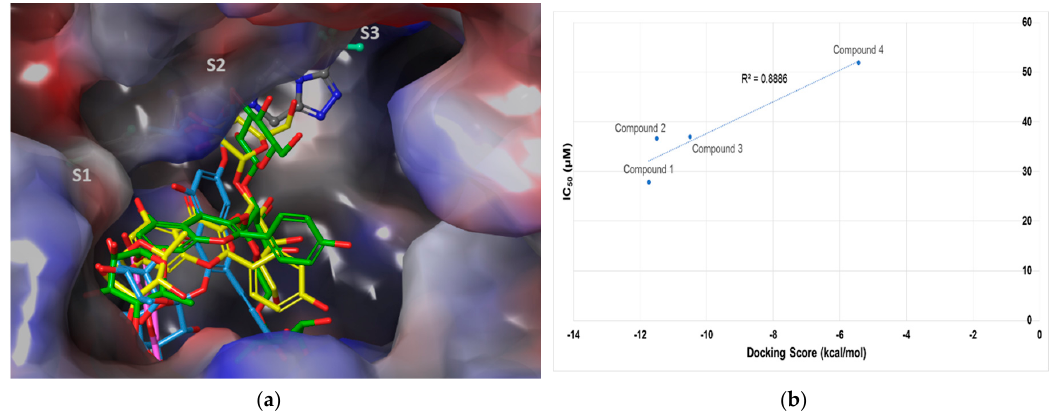
Figure 3. ( a ) The binding poses of all docked compounds in the binding pockets/active sites of human dipeptidyl peptidase IV. The binding pockets/active sites are labeled as S1, S2, and S3 (light grey). They are shown on the electrostatic surface. Sitagliptin is shown partially bound in the S3 pocket (grey atom-colored stick), and compounds 1 (yellow), 2 (green), 3 (light blue), and 4 (pink) are all docked into the wide S1 and S2 pockets. ( b ) Linear correlation between the docking scores and IC 50 values, with R 2 = 0.8886 for compounds 1 – 4 .